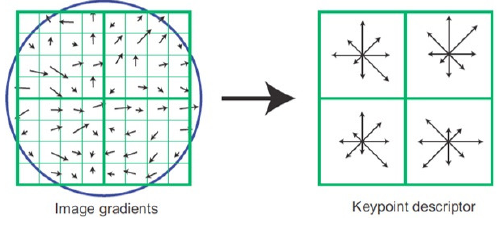
Figure 2: SIFT descriptor